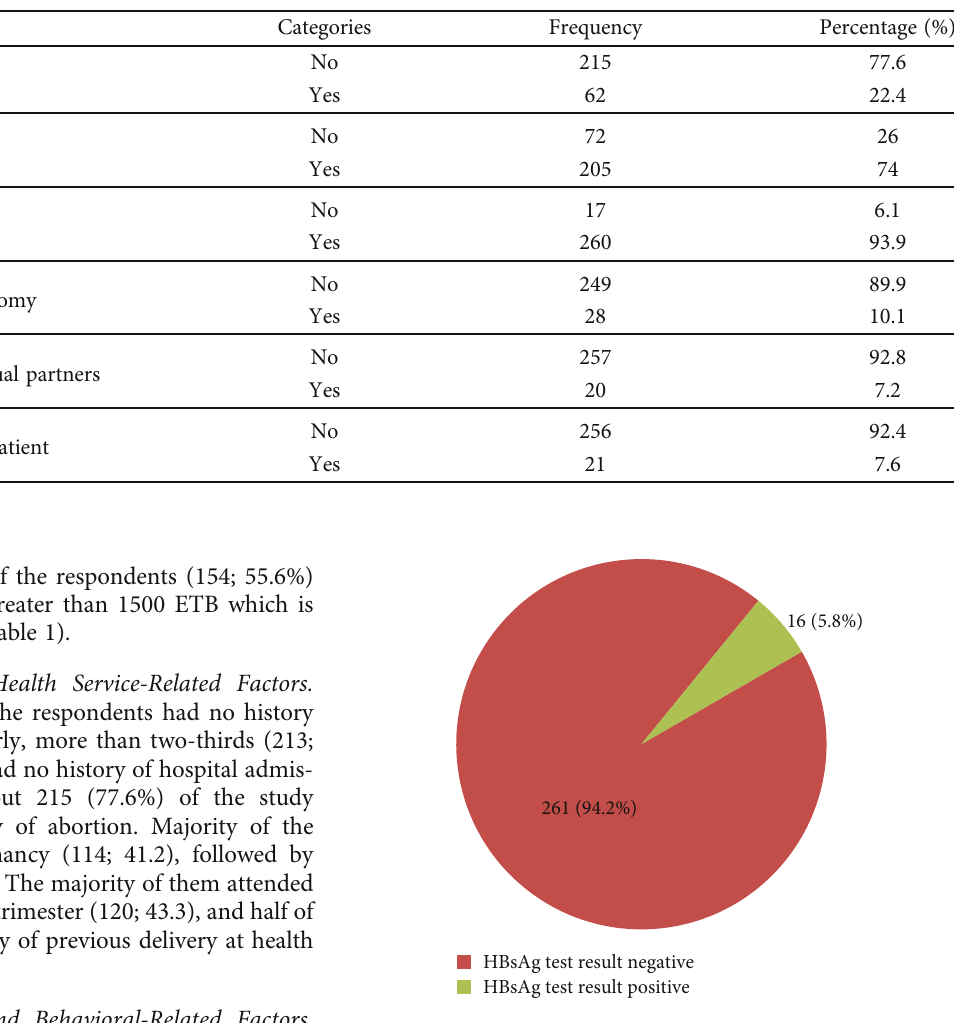
Table 3: Traditional practices and behavioral-related factors of HBV among pregnant women attending ANC services at public health facilities in Nekemte town, western Ethiopia, 2020.